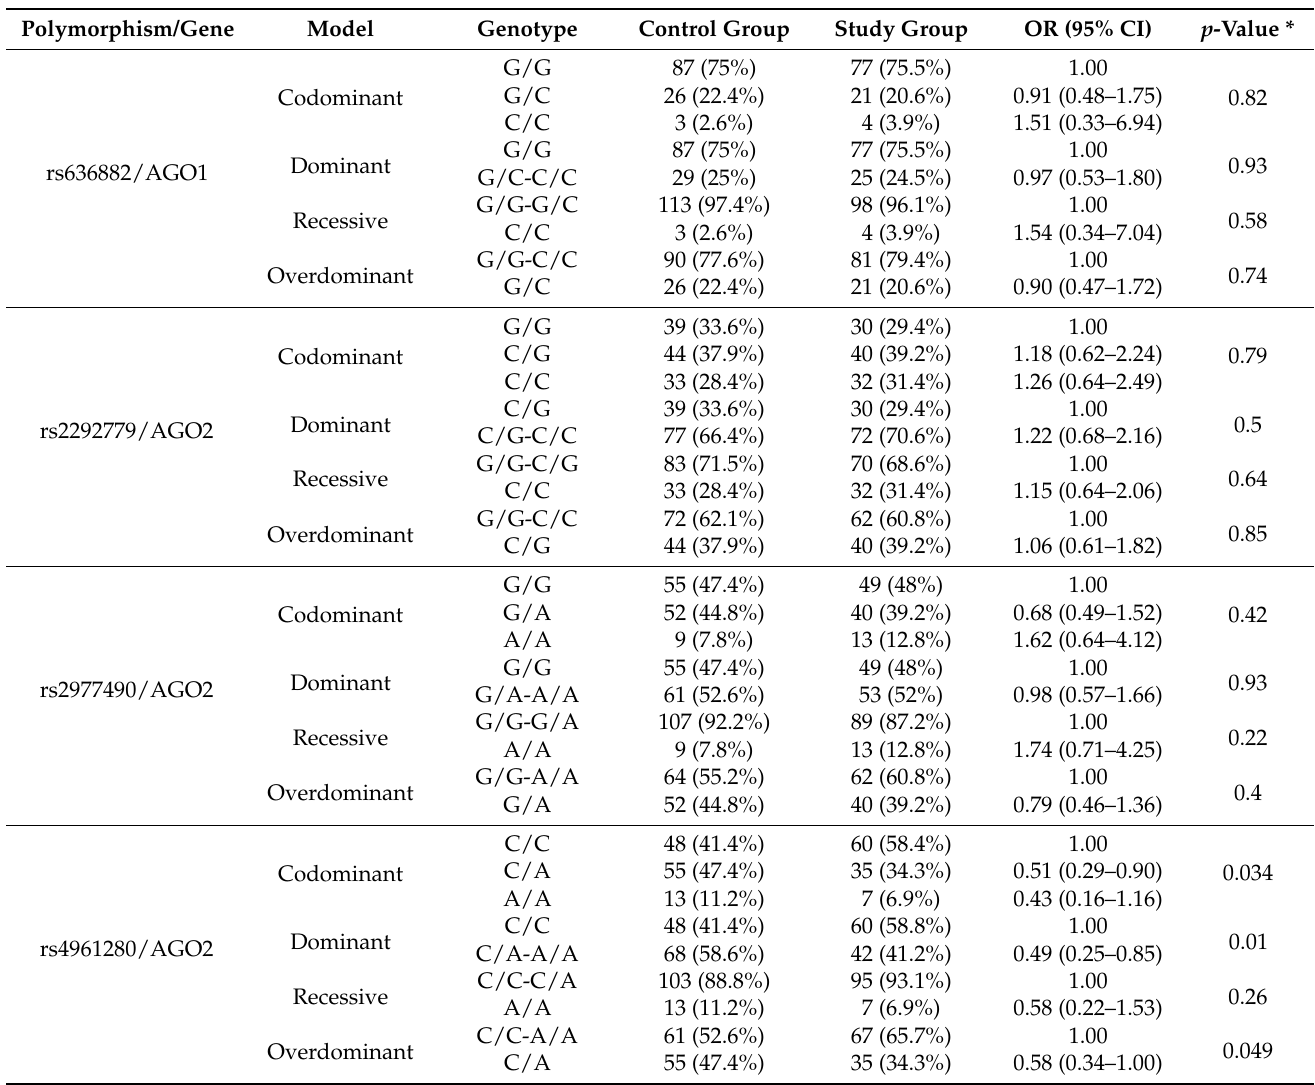
Table 2. Correlation of depression with the frequency of genotypes of the